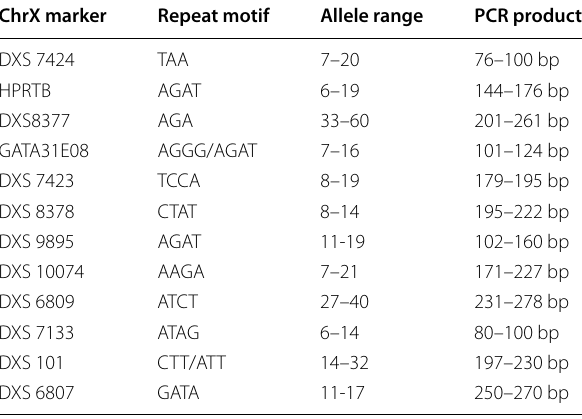
Table 2 Locus information of X‑STR markers ChrX